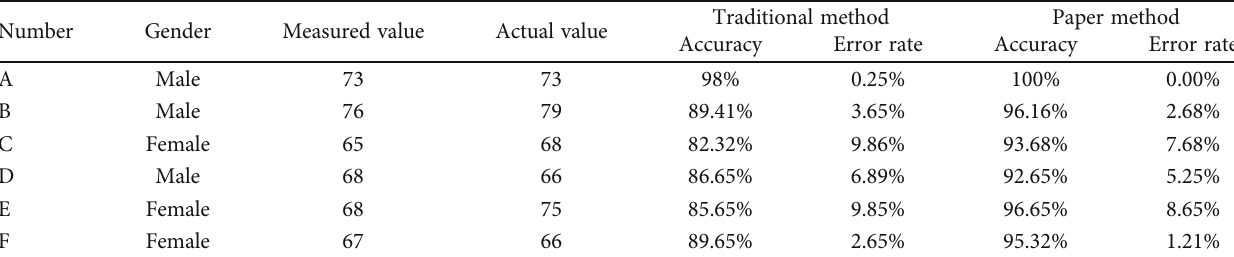
Table 4: Comparison of heart rate evaluation results of big